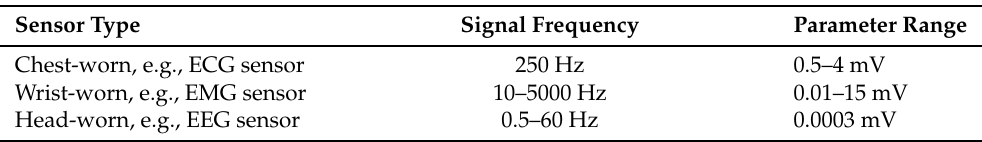
Table 1. Technical specifications for various wearable sensors to collect the necessary physiological biosignals required in educational studies, namely, ECG and heart rate variability, EMG and EEG. Sensor